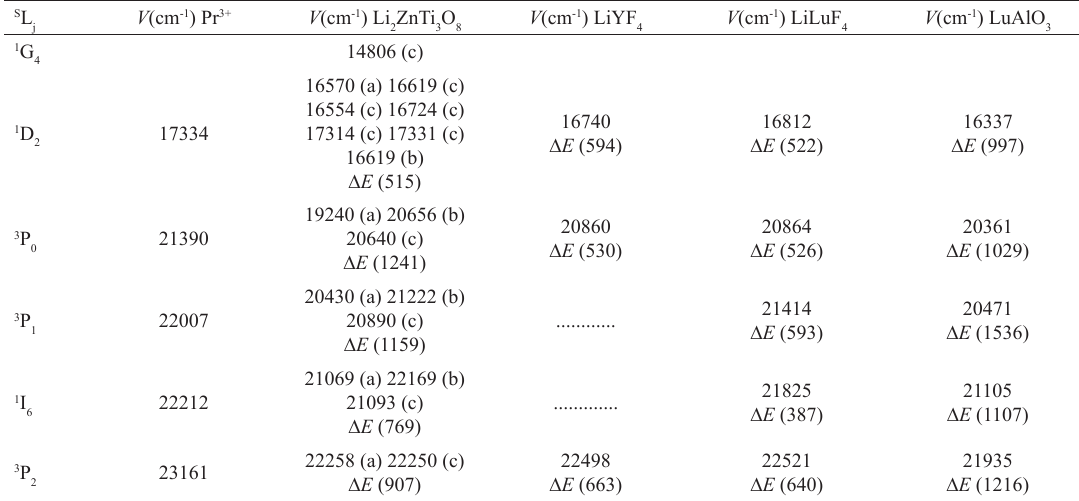
ZnTi O , LiYF , LiLuF and LuAlO 2 3 8 4 4